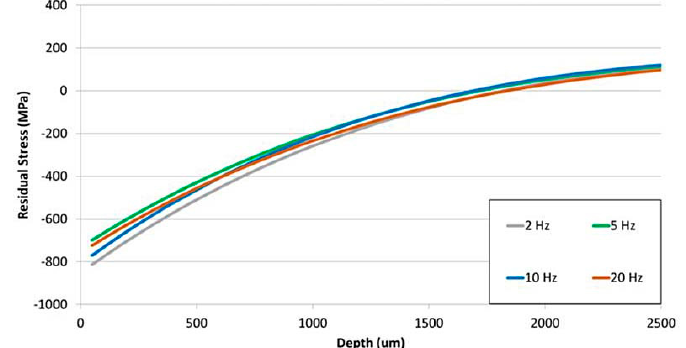
Figure 21. Residual stress profiles in 19 mm-thick Ti-6Al-4V coupons produced by the Procudo Laser Peening System applied at 1, 5, 10, and 20 Hz.